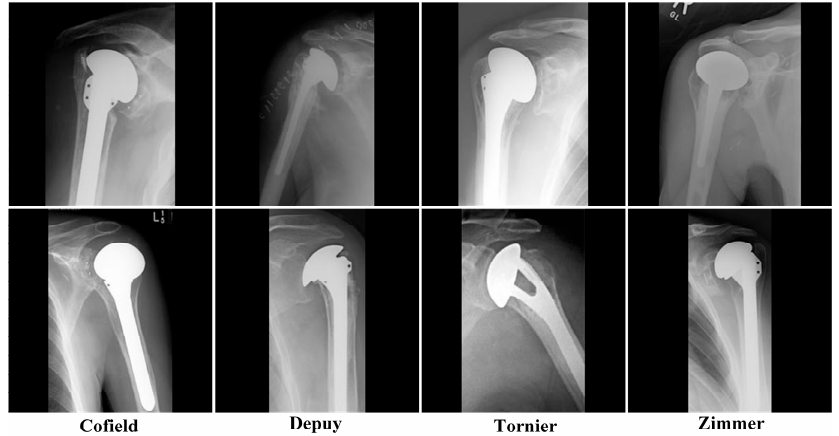
Figure 1. Samples from the dataset.